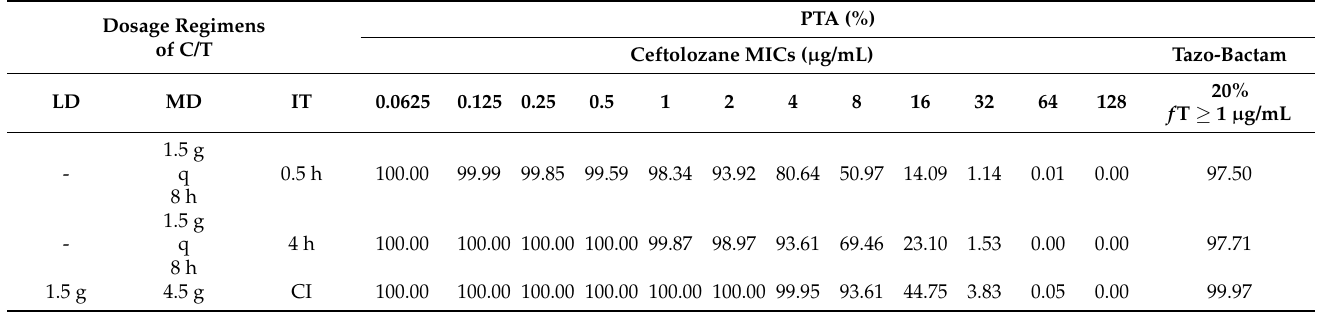
Table 4. The probability of target attainment (PTA), including 75% f T > MIC for ceftolozane and 20% f T ≥ 1 µ g/mL for tazobactam, at specific MICs for each dosing regimen.